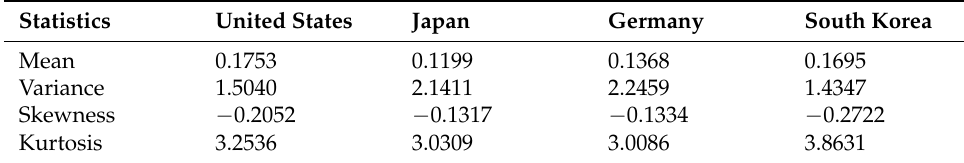
Table 2. Descriptive statistics of the daily index